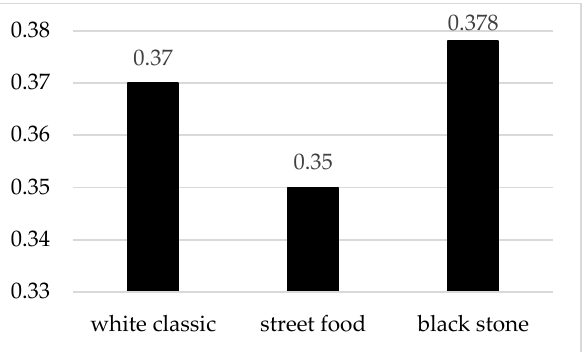
Figure 7. Level of excitement during the evaluation of waffles served in three different ways.